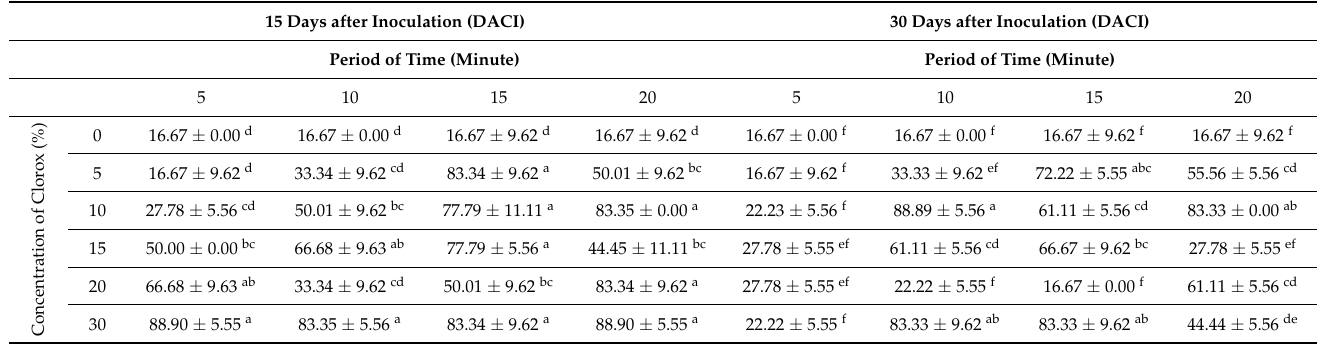
Table 8. Effect of different concentrations of Clorox used as a surface sterilizing agent for different periods of time on the survivability of stevia explants